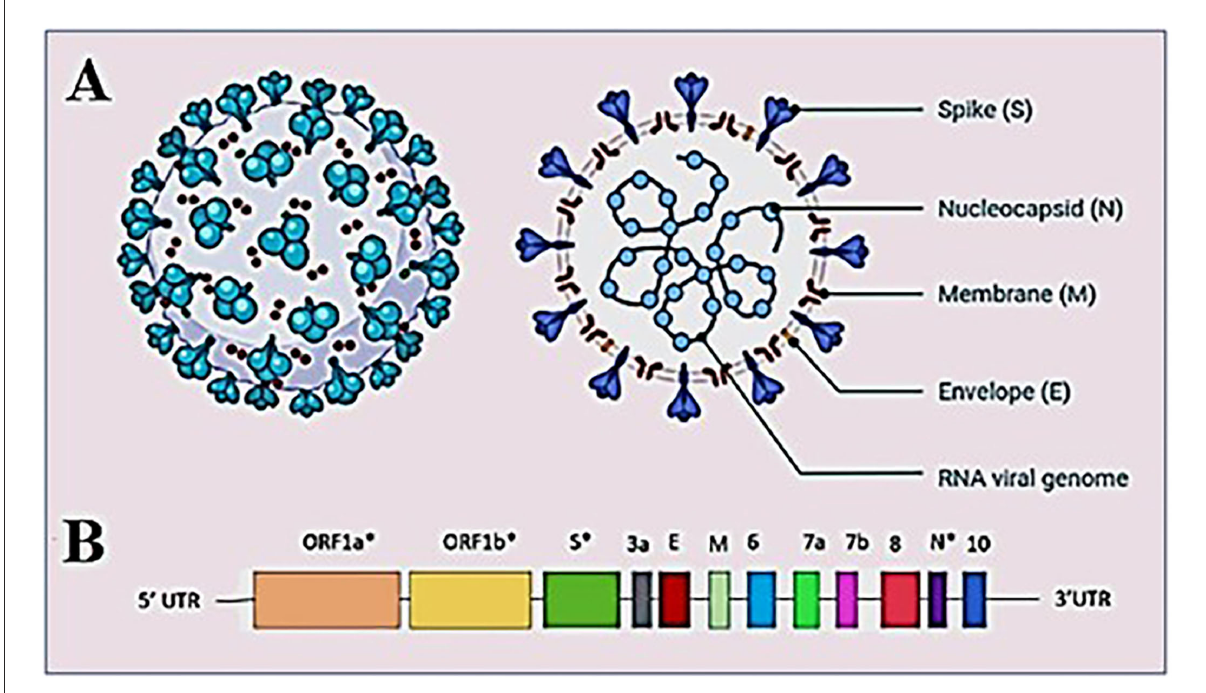
FIGURE2 Structure of SARS-CoV-2 virus (A) structure of SARS-CoV-2 virion showing the structural proteins, Spike (S), Membrane (M), and Envelope (E) embedded in the host-derived lipid bilayer and Nucleocapsid (N) interacts with the RNA viral genome present at the core of the brain. (B) A schematic overview of the SARS-CoV-2 genome structure. *Showing mutation hotspots across the